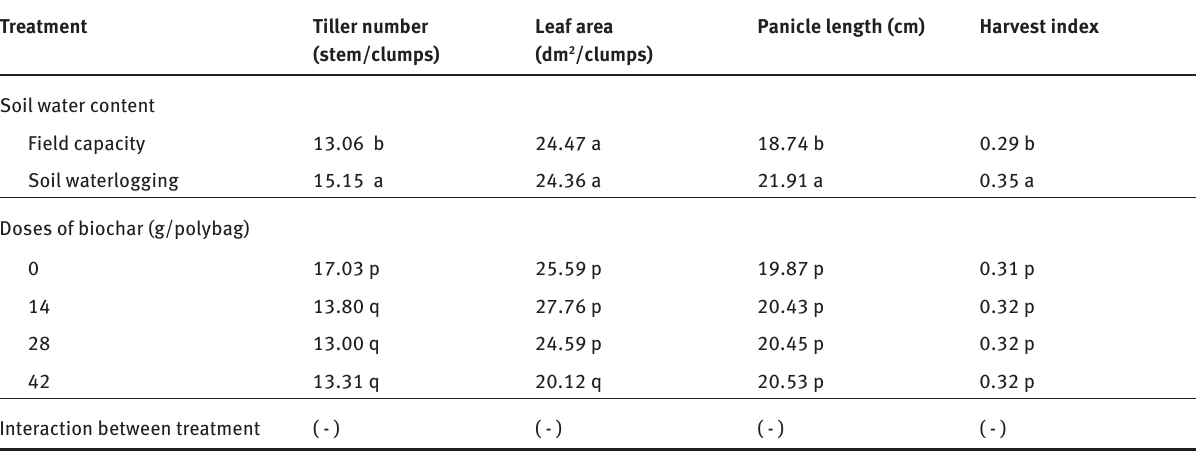
Table 1: The Effect of Soil Water Content and biochar application on the Tillers Number, Leaf Area, Panicle Length and Harvest Index